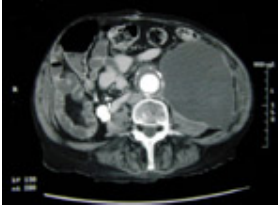
FIGURE 2. Contrast CT scan (5 weeks later) showing the large urinoma adjacent to the Dacron graft used for the AAA